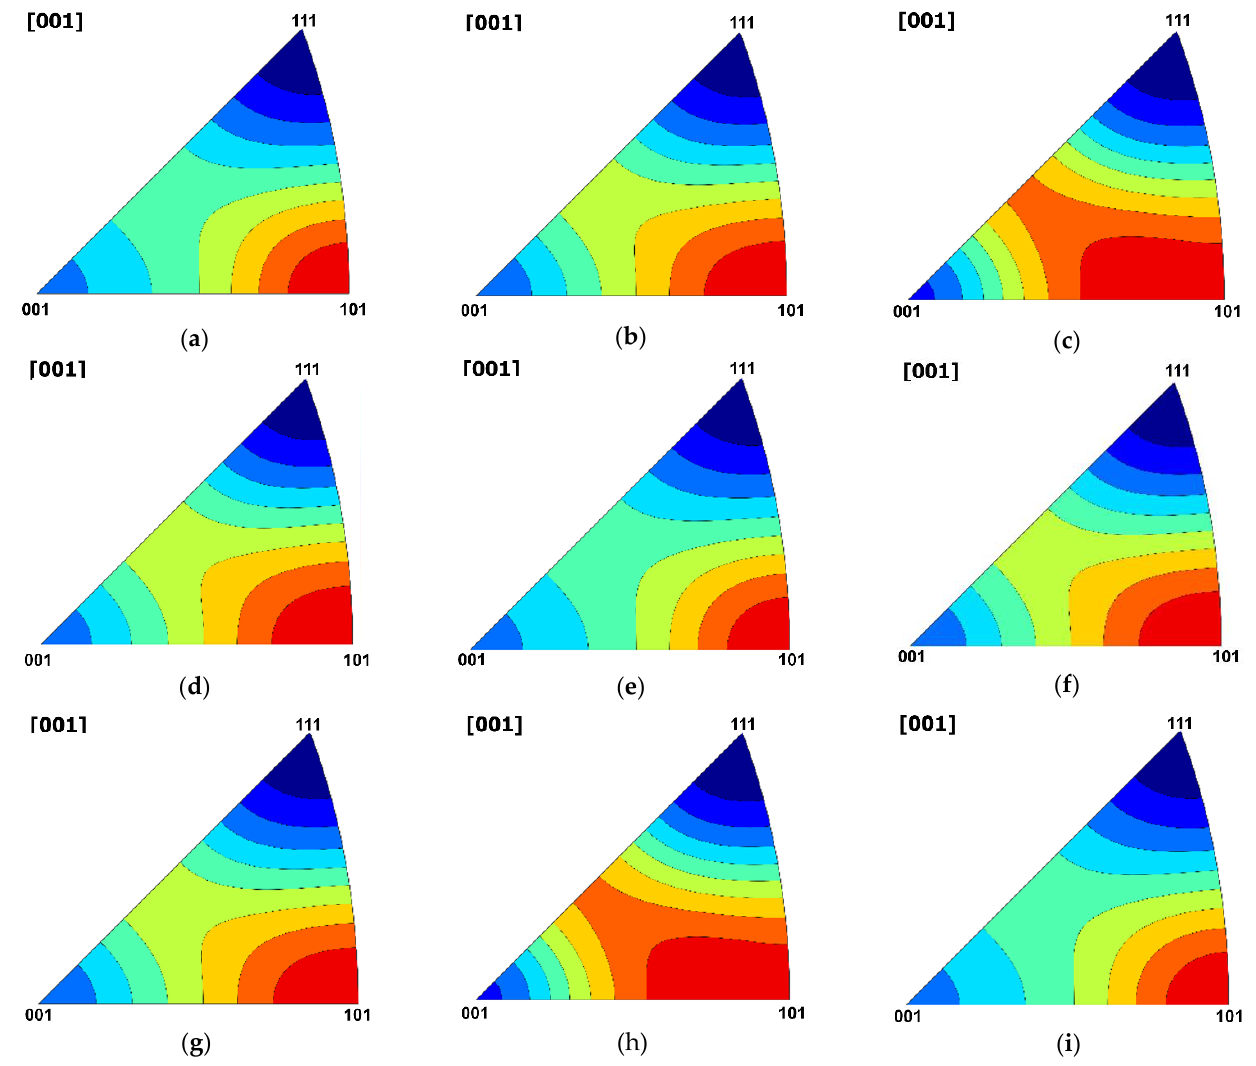
Figure 13. IPF of hot compression deformation simulated by VPSC. (The subgraph captions ( a – i ) correspond to the experimental groups (1) to (9) in Table 2, respectively).